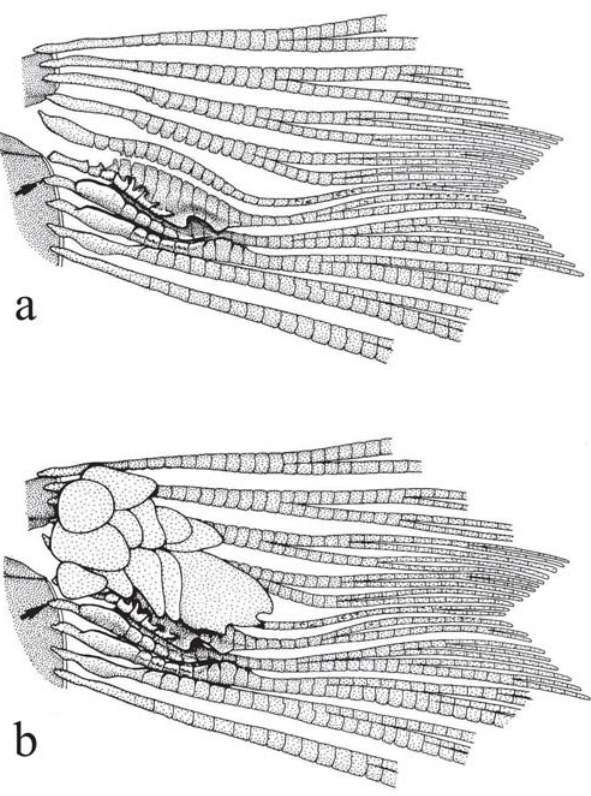
Fig. 75. Mimagoniates rheocharis , adult male, USNM 279879, paratype, 45.4 mm SL; osteology of central basal region of caudal-fin skeleton, principal fin rays 6-15, lateral view, left side, anterior at left. Principal caudal-fin ray 12 indicated by arrow. (a) Illustrates area of fully developed caudal organ. (b) Illustrates relationship of modified dorsal-fin squamation to pump chamber skeleton. Modified from Menezes & Weitzman (1990).